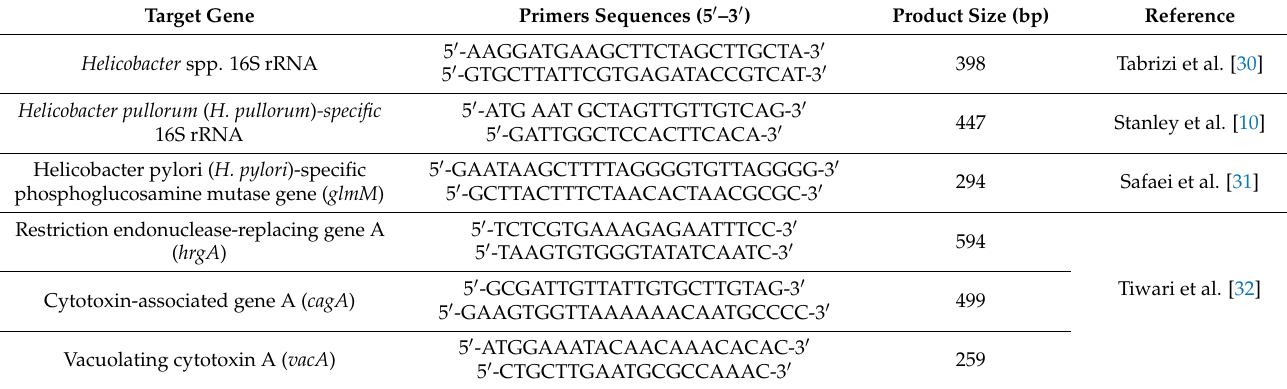
Table 1. Primers used in this